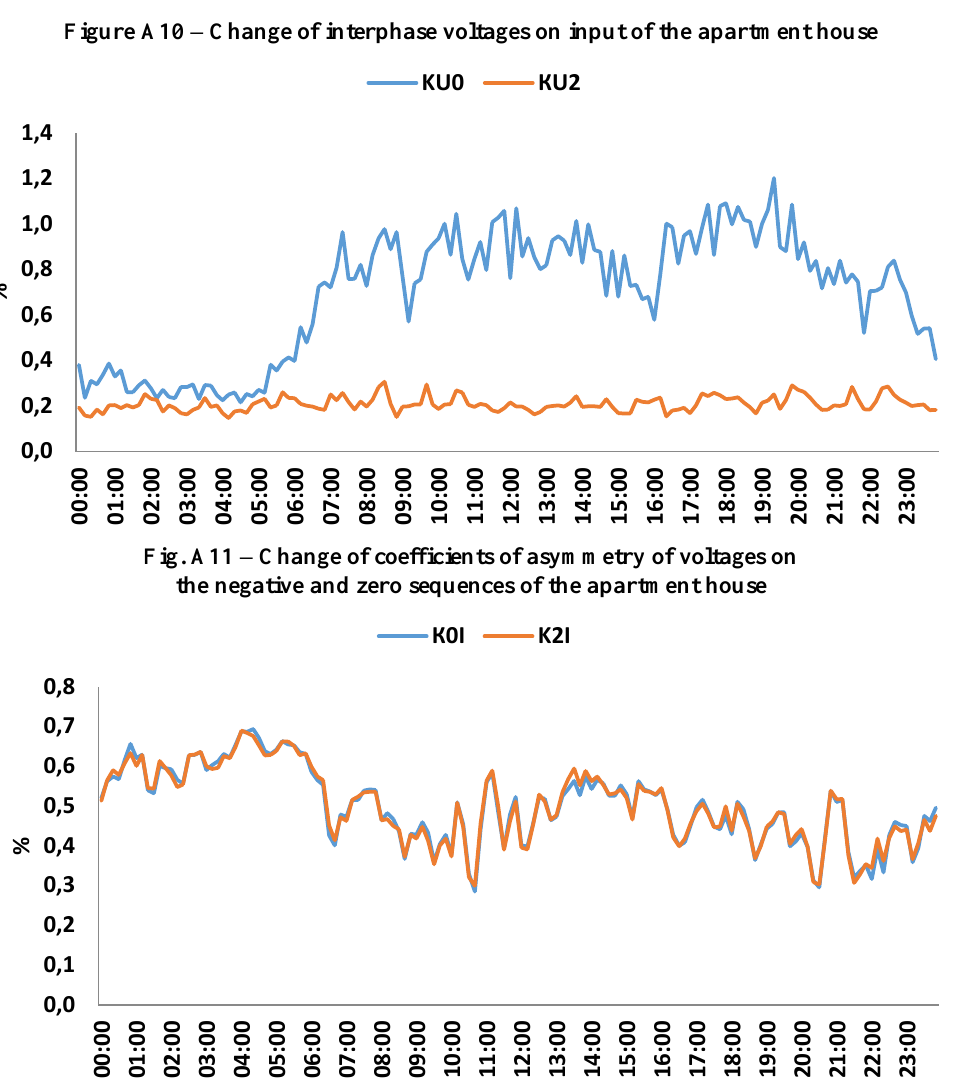
Fig. A12 – Change of coefficients of asymmetry of currents on the negative and zero sequences of the private